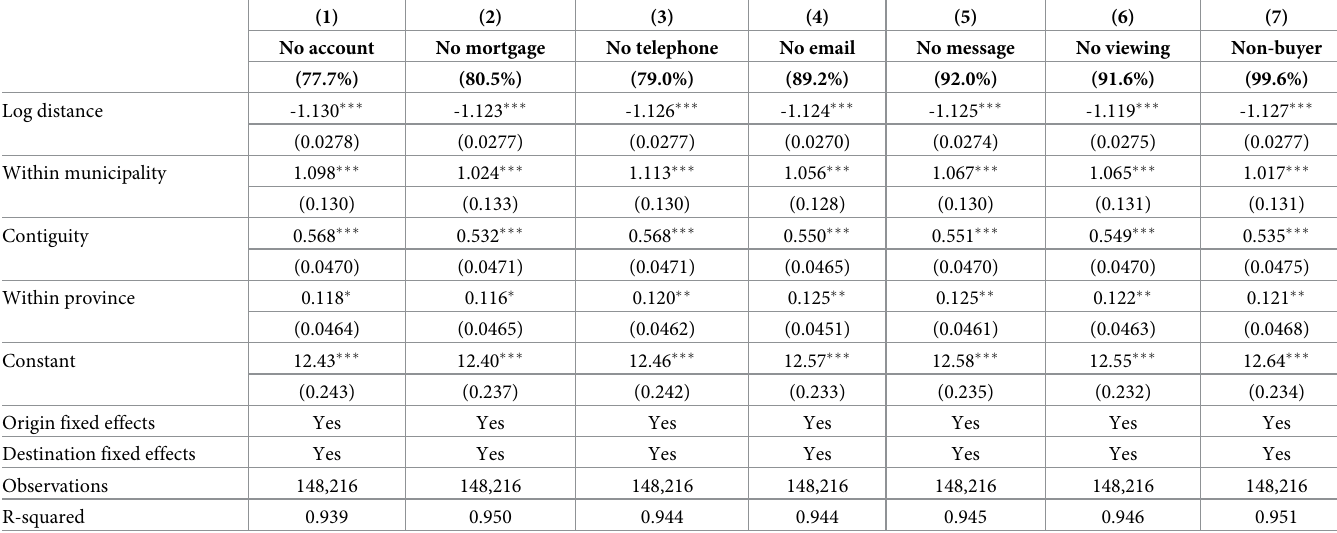
Table 6. Poisson pseudo maximum likelihood estimates for recreational